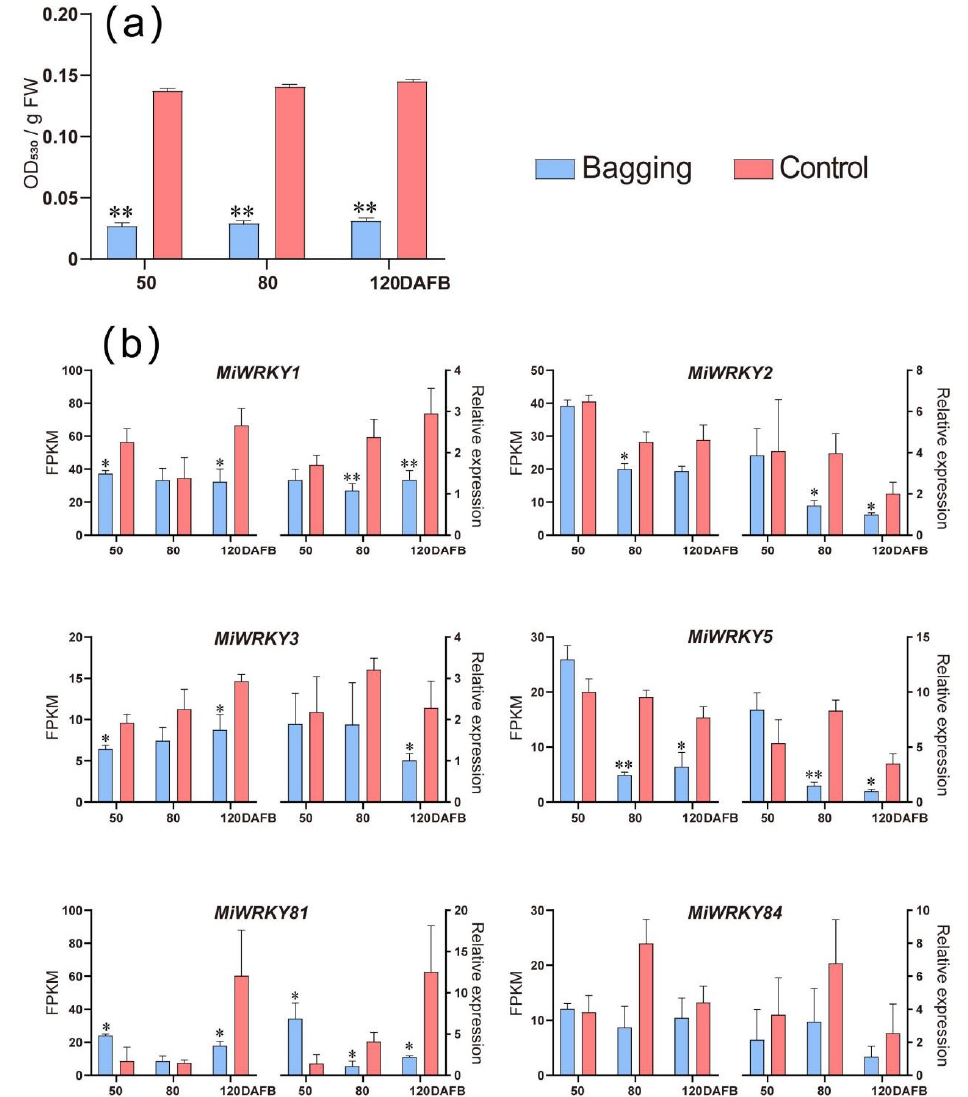
Figure 7. ( a ) The contents of anthocyanin in bag-treated and control ‘Sensation’ mango peel. ( b ) Q-PCR validation of candidate expressed genes in ‘Sensation’ mango peel detected by RNA-Seq. The RNA-Seq data (left) are shown with the Q-PCR data (right). The data represents the mean ± standard deviation with n = 3. * represents significant difference ( p -value < 0.05); ** represents highly significant difference ( p -value < 0.01), as determined by Student’s t -test. The expression levels of six MiWRKYs were also detected in three different colored mango cultivars, including ‘Guifei’ (red), ‘Jinhuang’ (yellow), and ‘Qingmang’ (green) (Figure 9a). The expression of MiWRKY2 showed no difference among the three cultivars. MiWRKY2 , MiWRKY3 , MiWRKY5 , MiWRKY81 , and MiWRKY84 were highly expressed in ‘Guifei’ but were not well expressed in the non-anthocyanin accumulated cultivars, ‘Jinhuang’ and ‘Qingmang’ (Figure